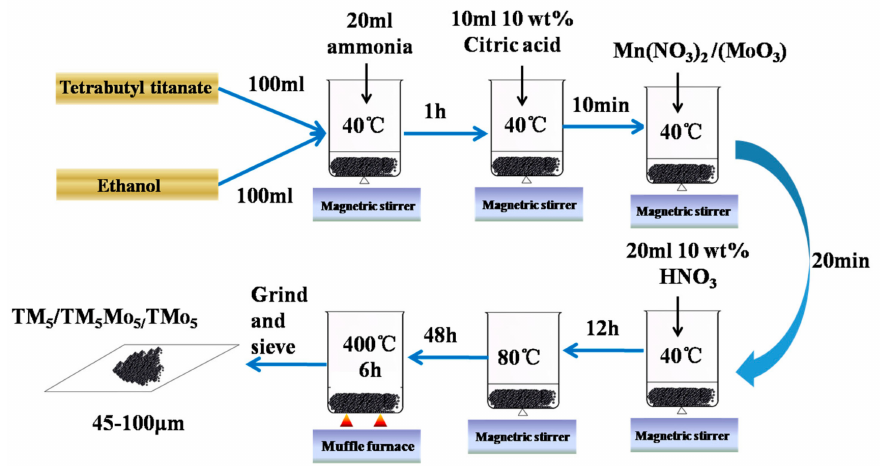
Figure 10. The progress of catalysts